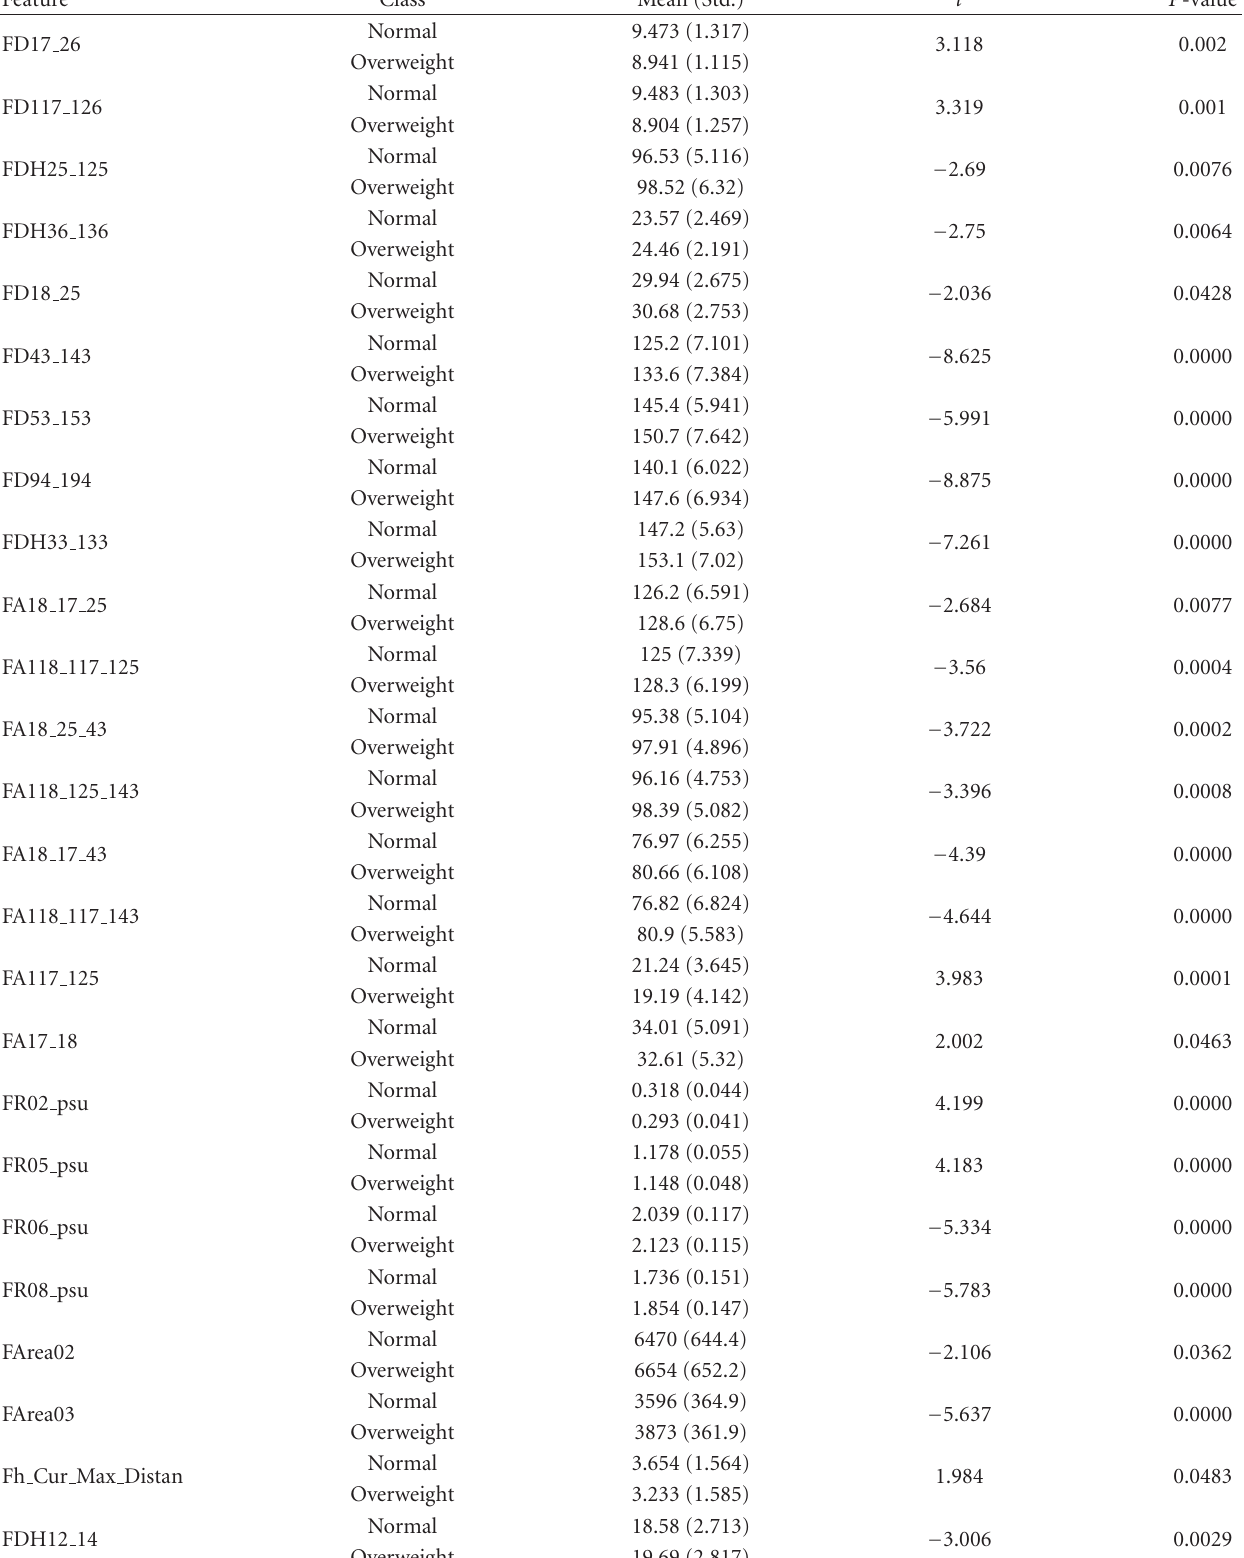
Table 5: Statistical analysis of female: 21–40 group by an independent two-sample t -test (Std.: standard deviation).